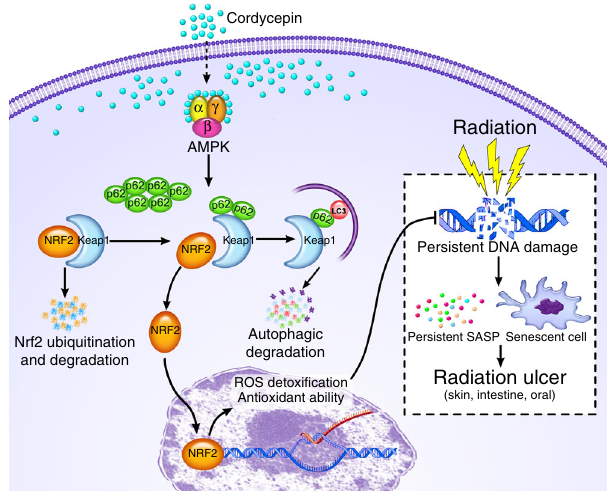
Fig. 9 Proposed model of cordycepin as radiation ulcer mitigator by preventing cell senescence. Persistent DNA damage foci forms and senescent cells accumulate in radiation ulcer, which involved in the development of radiation ulcer. Cordycepin activates AMPK by directly binding to AMPK protein via interacting with the α 1 and γ 1 subunit near the autoinhibitory domain (AID), activated AMPK promotes p62-dependent autophagic degradation of Keap1, thus, NRF2 dissociates from Keap1 and moves to the nucleus, where it transactivates ARE-containing